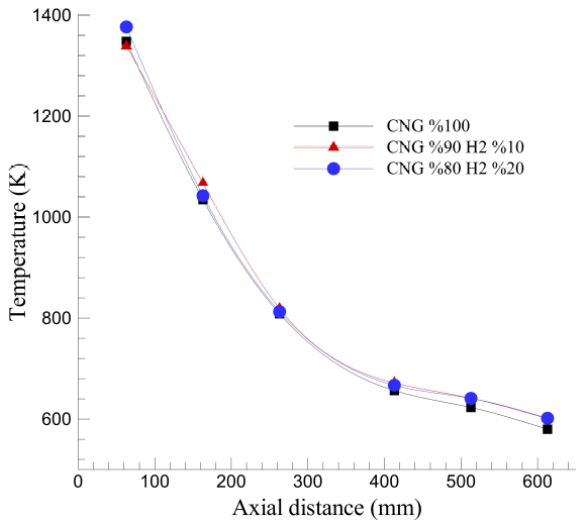
Figure 4: Axial temperature distributions (Swirl number: 0.4, Equiv- alence ratio: 1.0).